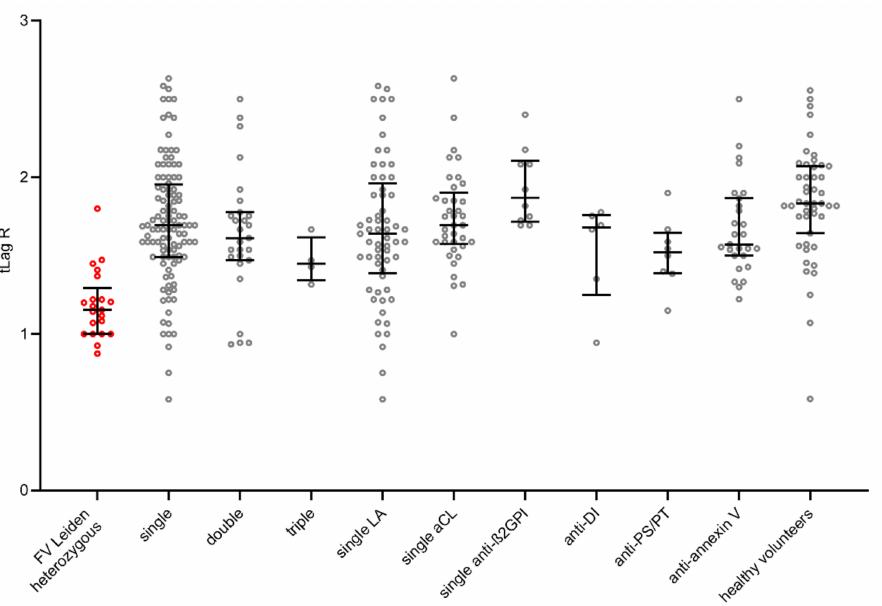
Figure 1. Visualization of TGA tLag R in each group by scatter dot plots including median and quartiles. TGA: thrombin generation assay; tLag R: lag phase 1/(tLag − APC/tLag + APC). The group of FV Leiden heterozygotes as a standard of thrombogenicity is shown by the red shaded points. We have used the 21 patients with known hereditary thrombophilia with